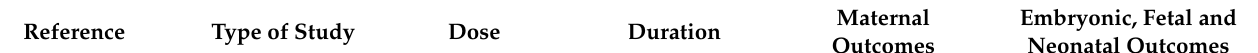
Table 4. Studies using quercetin in the treatment of models of complicated pregnancies, including preeclampsia. The up arrow ↑ represents increase, down arrow ↓ represents